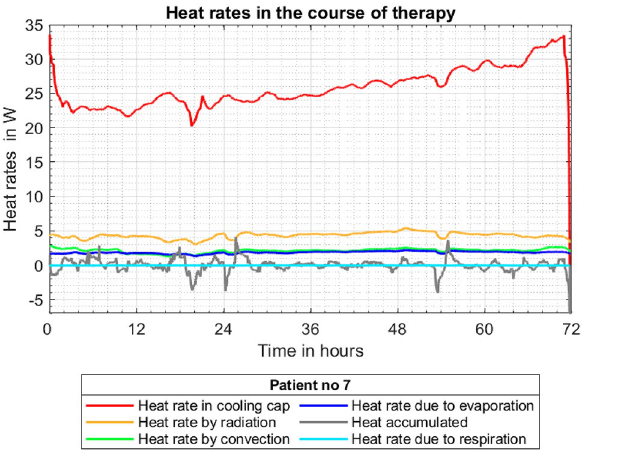
Figure 7. Heat rates in the course of